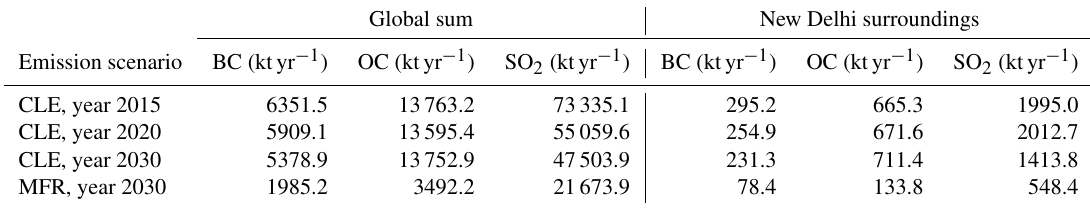
Table 1. ECLIPSE V6b emissions and global yearly sums for current legislation (CLE) scenario emissions for the years 2015, 2020 and 2030 and for the maximum feasible reduction (MFR) scenario for the year 2030. The second column shows the global summed emitted mass, and the third column represents the summed emitted mass for New Delhi surroundings (24–34 ◦ N, 72–82 ◦